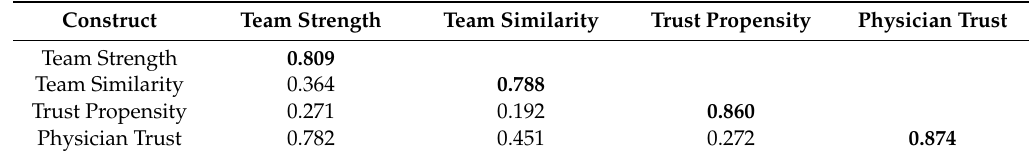
Table 4. Discriminant